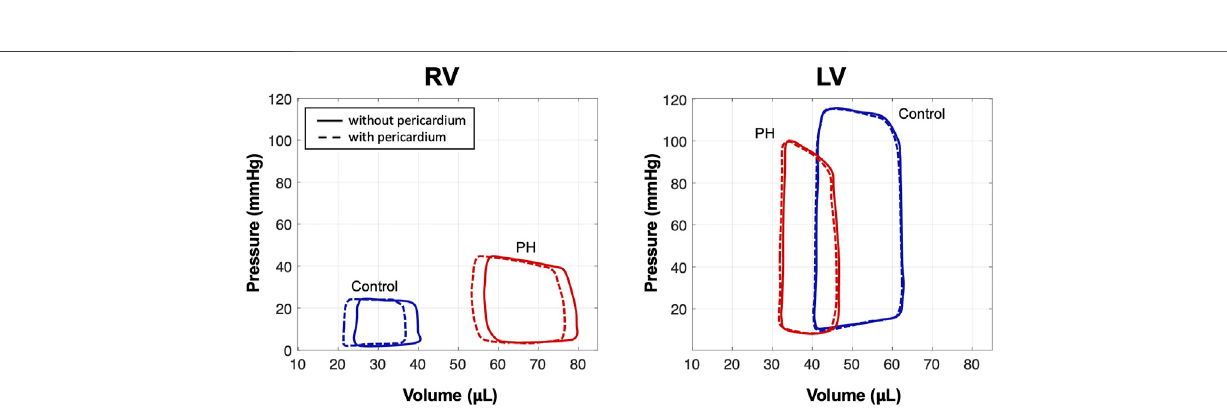
Frontiers in Physiology |